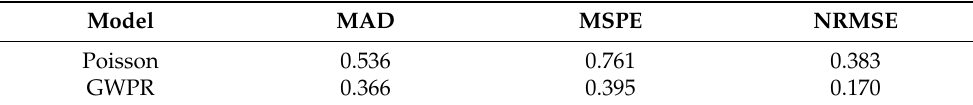
Table 3. Model overall performance of two models.